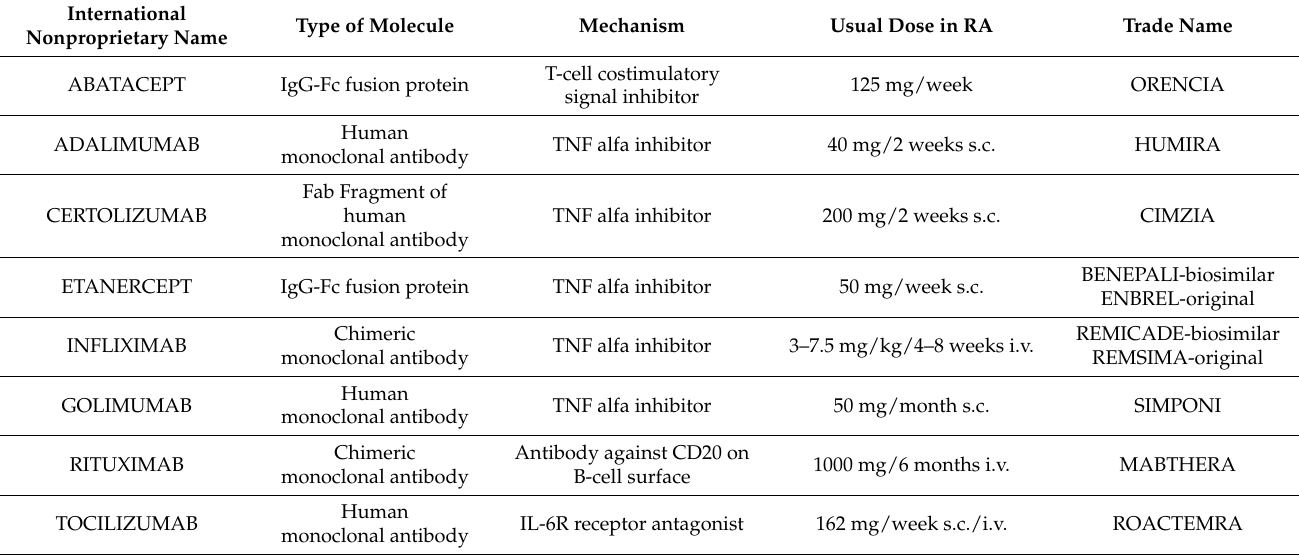
Table 1. Biological DMARDs (bDMARDs) used in